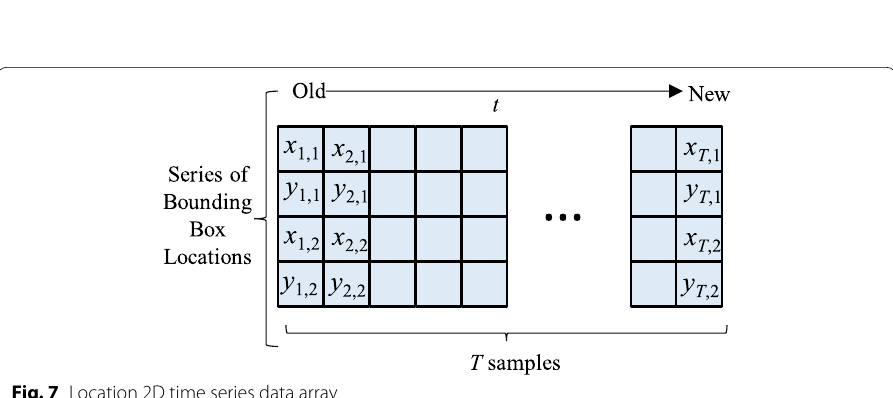
Fig. 7 Location 2D time series data